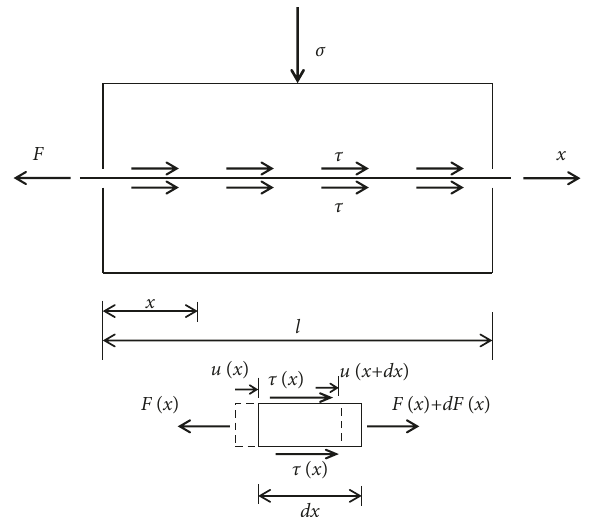
Figure 6: Schematic illustration of pullout mechanism of geogrid in